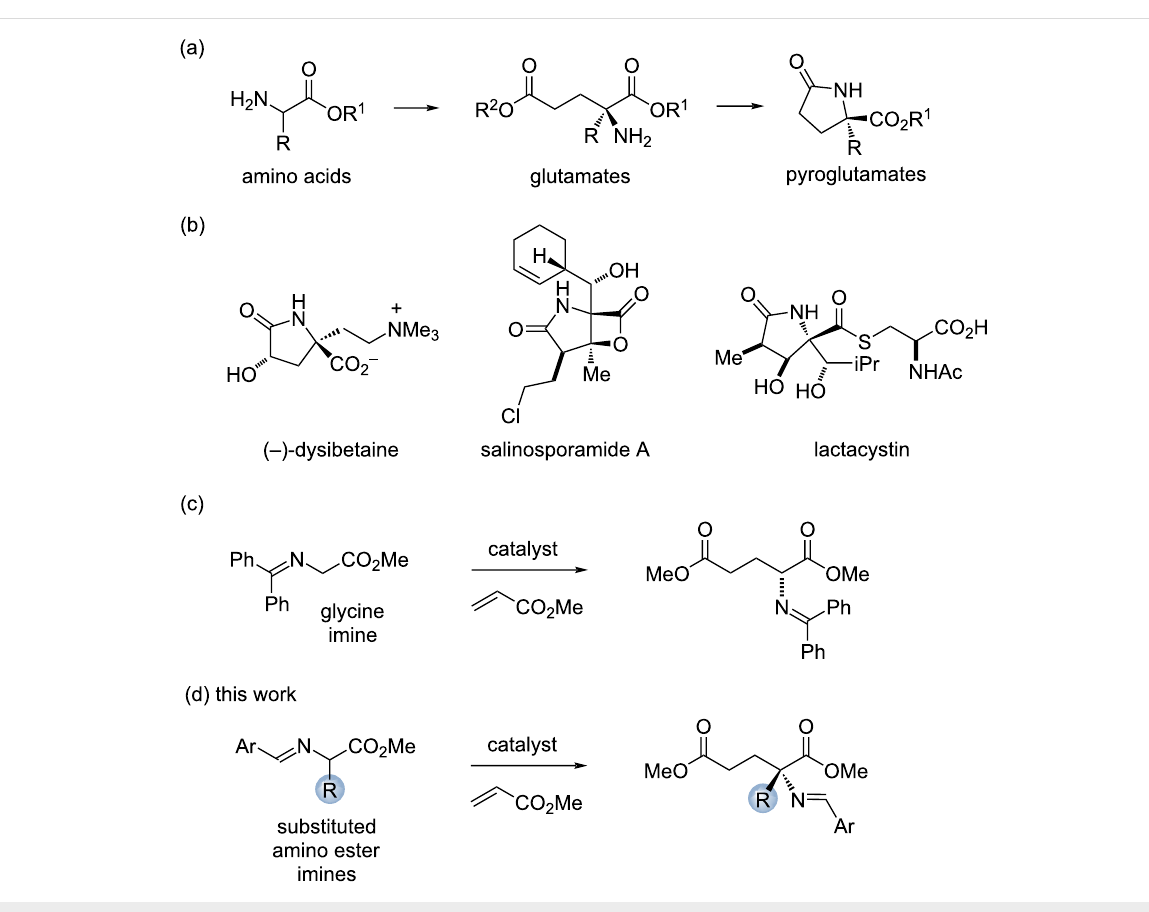
lectivities only up to 84% ee [36]. Phase-transfer catalysis